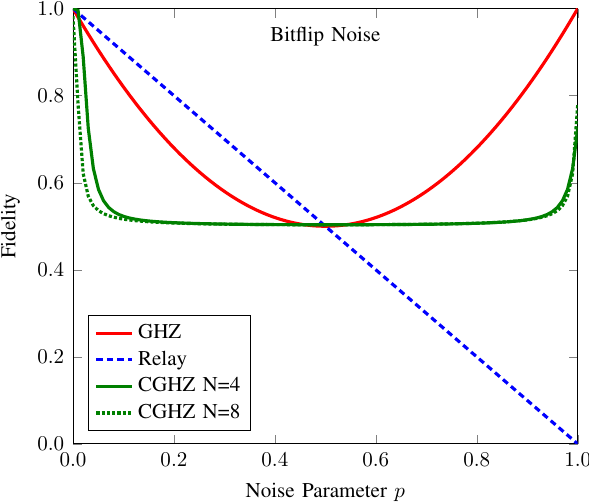
Figure 6. Fidelity of the anonymous entanglement of CAQT compared to those of conventional GHZ-based AQT and relay-based AQT under bit-flip noise. Here, the dotted (solid) line denotes the fidelity of anonymous entanglement when the number of participants N is 4 (8). The fidelity values of the anonymous entanglement of conventional GHZ-state-based AQT (GHZ), relay-based AQT (Relay), and our counterfactual GHZ-state-based AQT (CGHZ) are represented by the red, blue, and green lines, respectively. The conventional AQT protocols yield the same fidelity graph for both N = 4 and N =